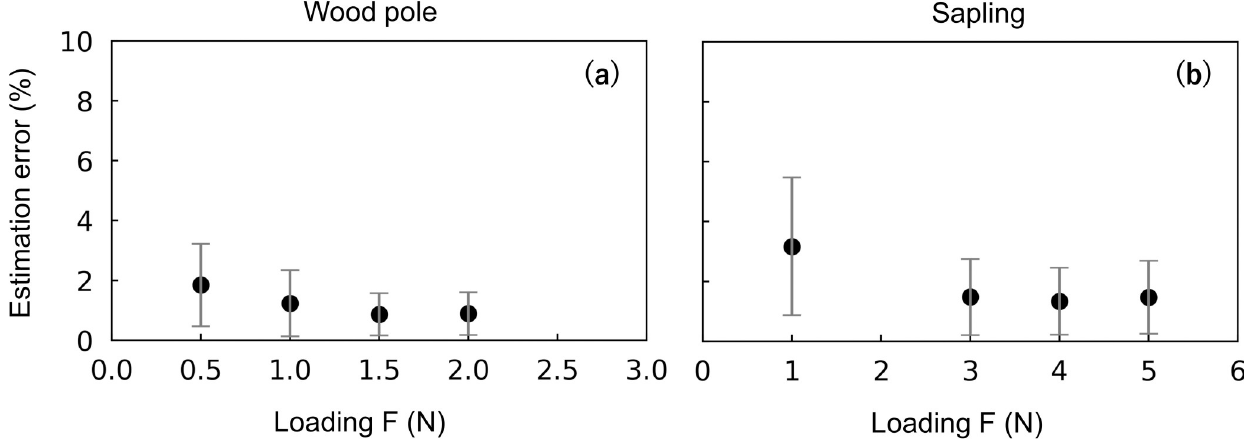
Fig 9. Estimation errors for the amount of force, F, versus the known loading values of force for the circumferential experiments. (a) Wood pole and (b) sapling. For the calculation of the estimation errors, see the caption of Figs 5 and 8.